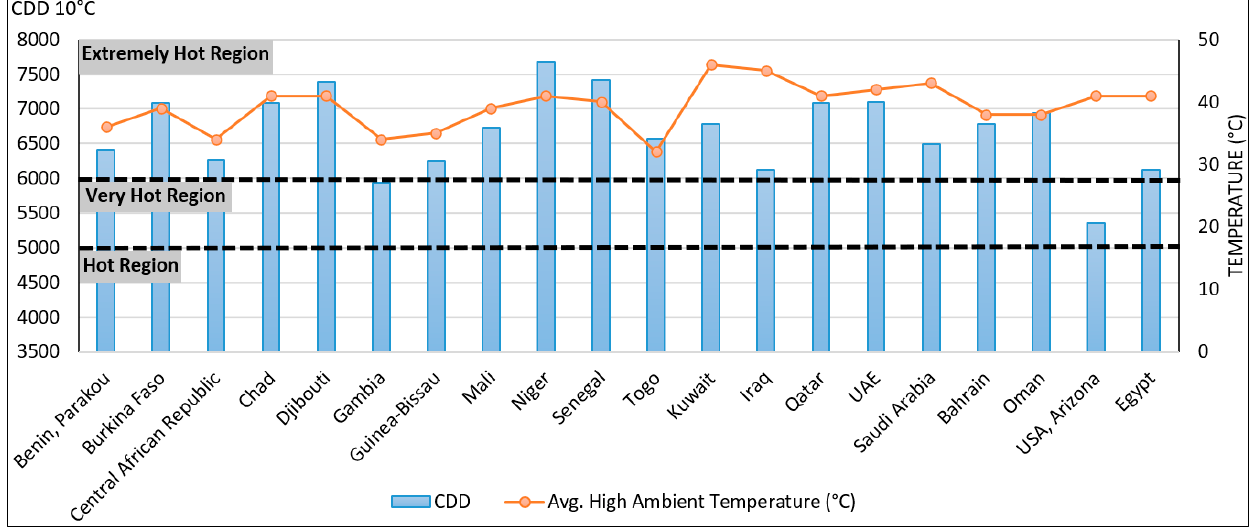
Figure 1. Average high ambient temperature for the hottest month of the year [18] and CDD°10 [19] for a number of high ambient temperature countries and regions.